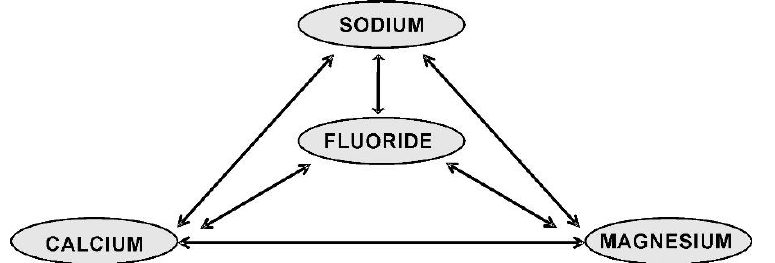
Figure 3 : Antagonistic relationship between of Ca, Mg, Na and